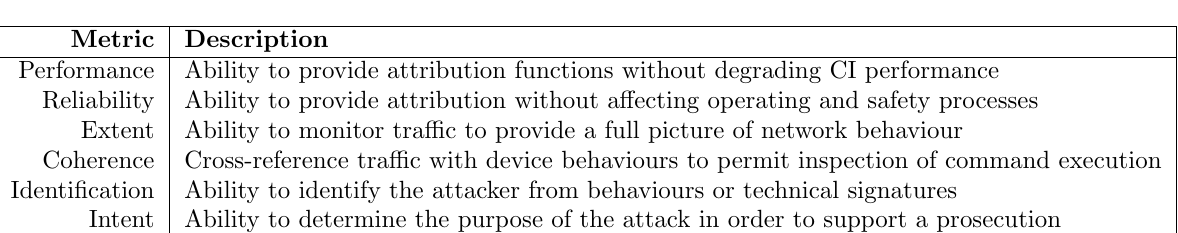
Table 1. Metrics of